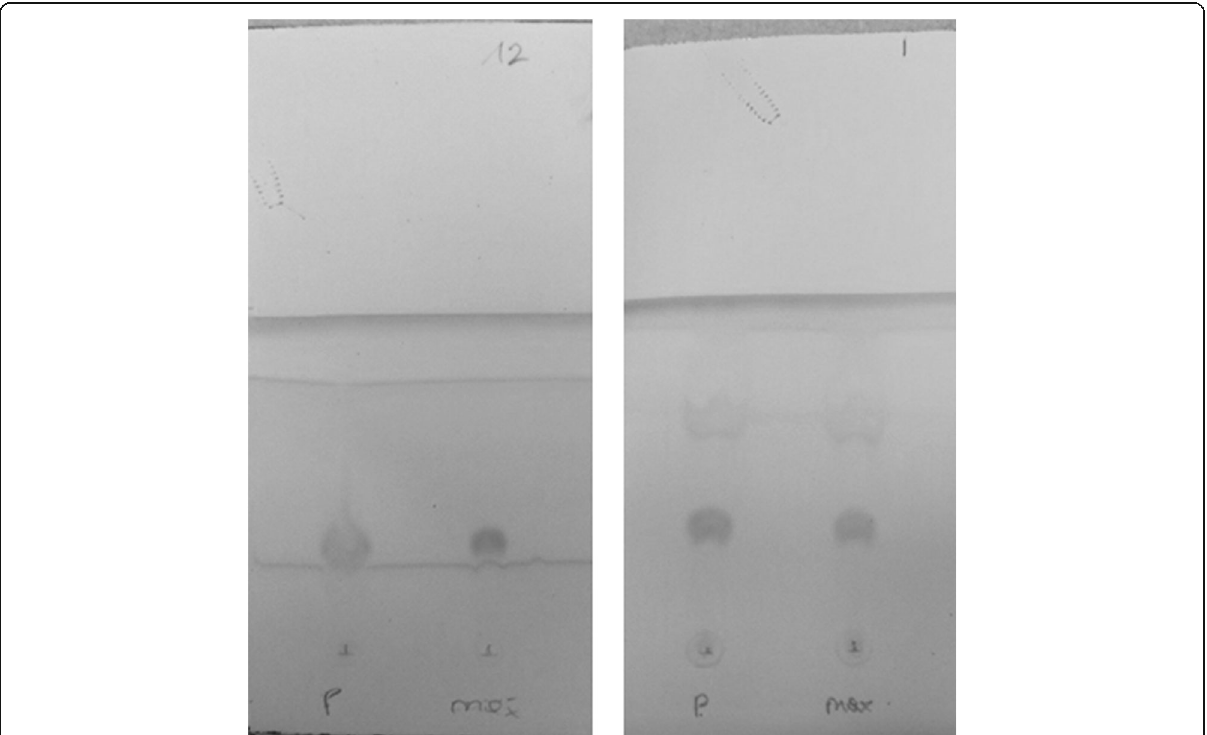
Fig. 6 Representative images of iodine-stained TLC plates (35 μ g/mL HEPES) with the sample ( “ P ” ) spotted in the left column and the maximum allowed concentration ( “ max, ” 25 μ g/mL in this experimental setup) in the right column of each plate. The plates were processed according to the Ph. Eur. (left image) and the improved method (right image) and were used for the operator